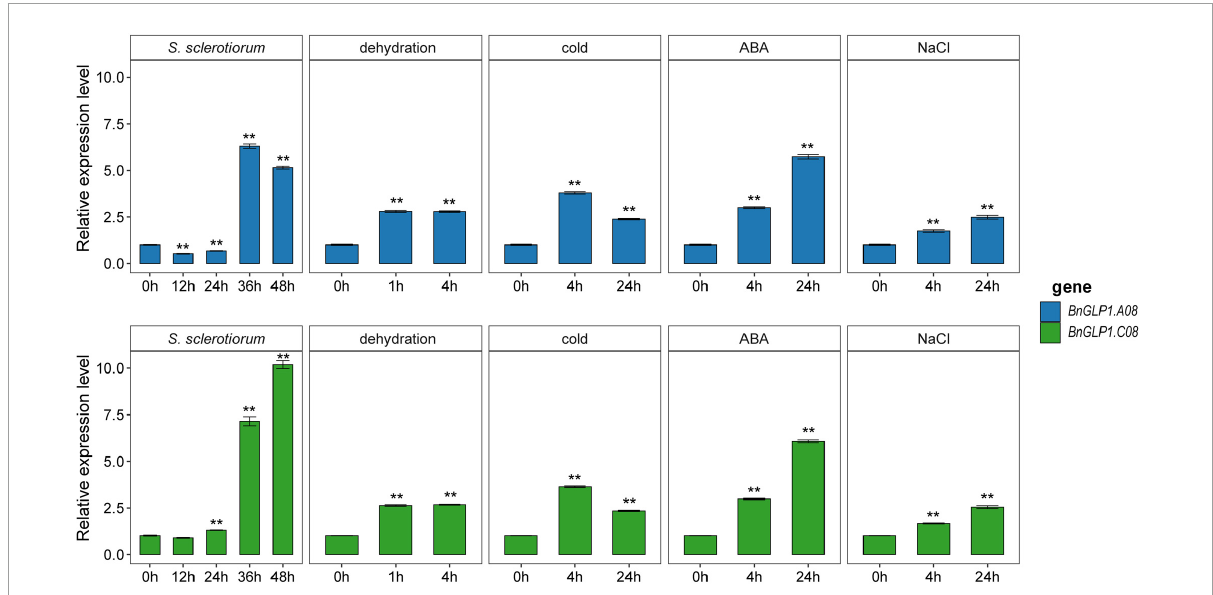
FIGURE8 The expression validation of candidate BnGLP1.A08 and BnGLP.C08 genes in response to Sclerotinia sclerotiorum infection and four abiotic stress treatments (dehydration, cold, ABA and salinity) by qRT-PCR. The time points under the x-axis represent hours (h) after corresponding biotic and abiotic treatments. The error bars show the standard error of three replicates. Student’s t -test was used for statistical analysis, ** indicates significant differences at P < 0.01, all compared to the treatment at 0